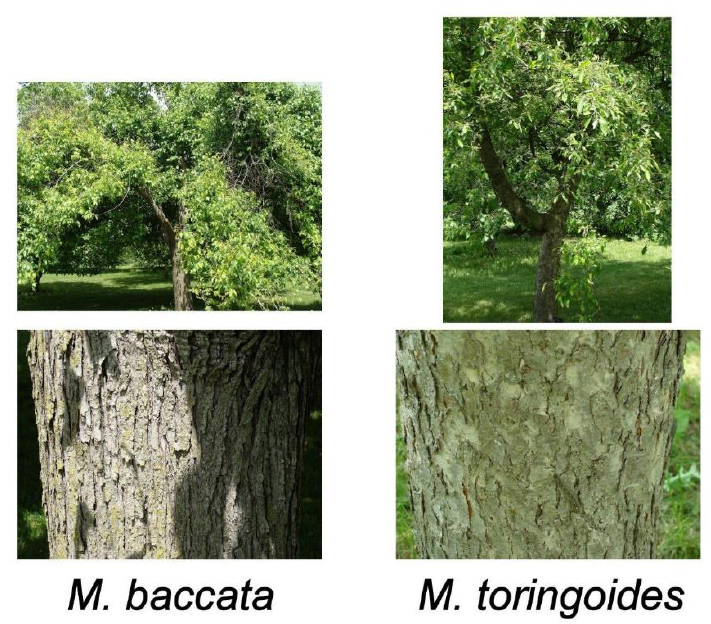
Figure 1. The morphological appearance of Malus baccata and Malus toringoides bark .